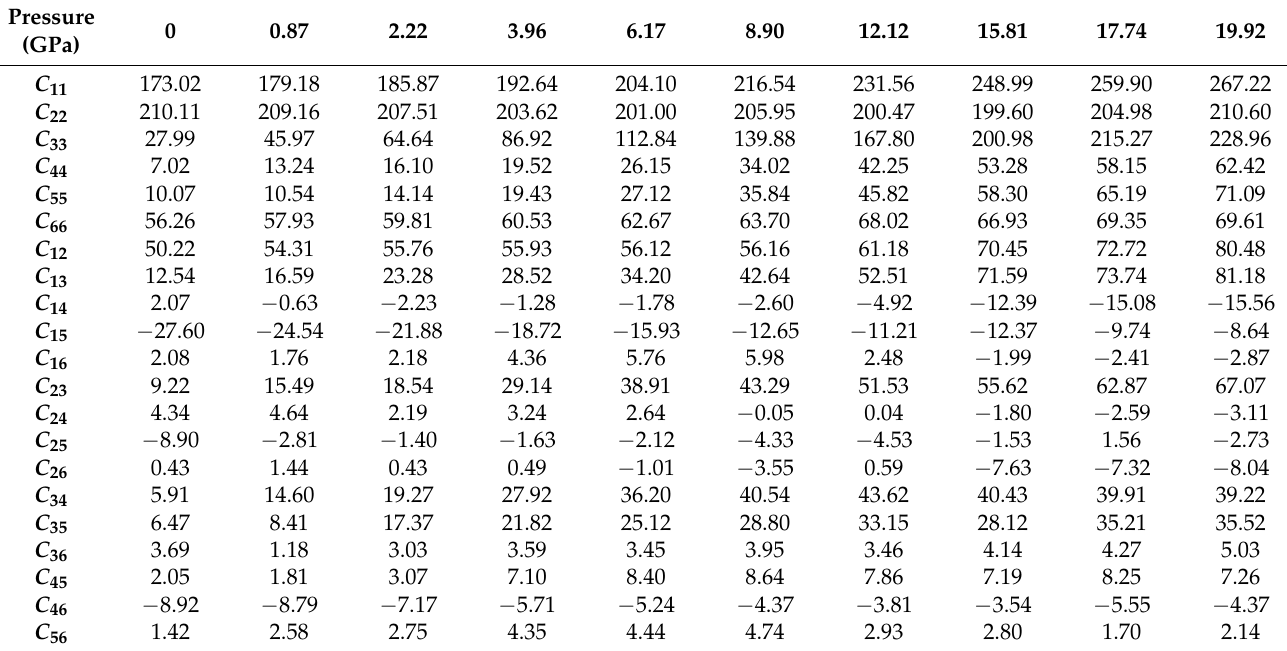
Table 11. The calculated elastic constants C ij of the Na-MMT under pressure.